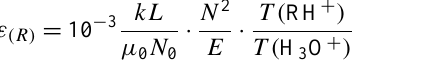
Due to the lower overall sensitivity, the total accuracy for formaldehyde at 1 ppbv is between 25 % (dry) and 50 % (hu-